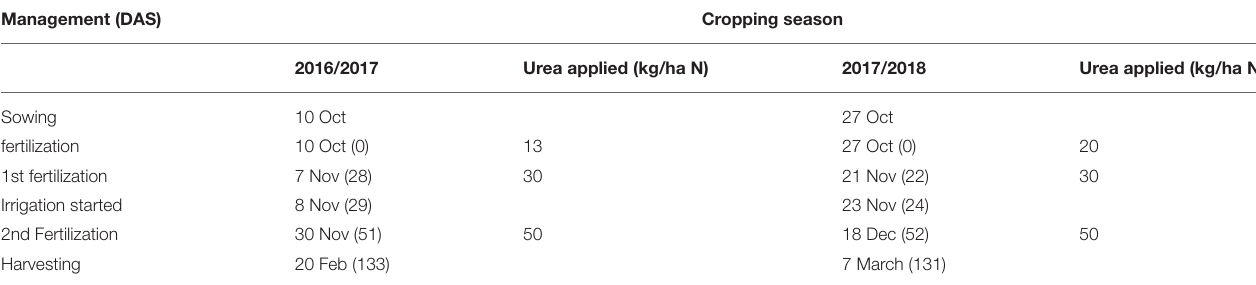
TABLE 3 | Agronomic management in 2016/2017 and 2017/2018 cropping seasons [numbers in brackets next to dates indicated days after sowing (DAS)]. Management